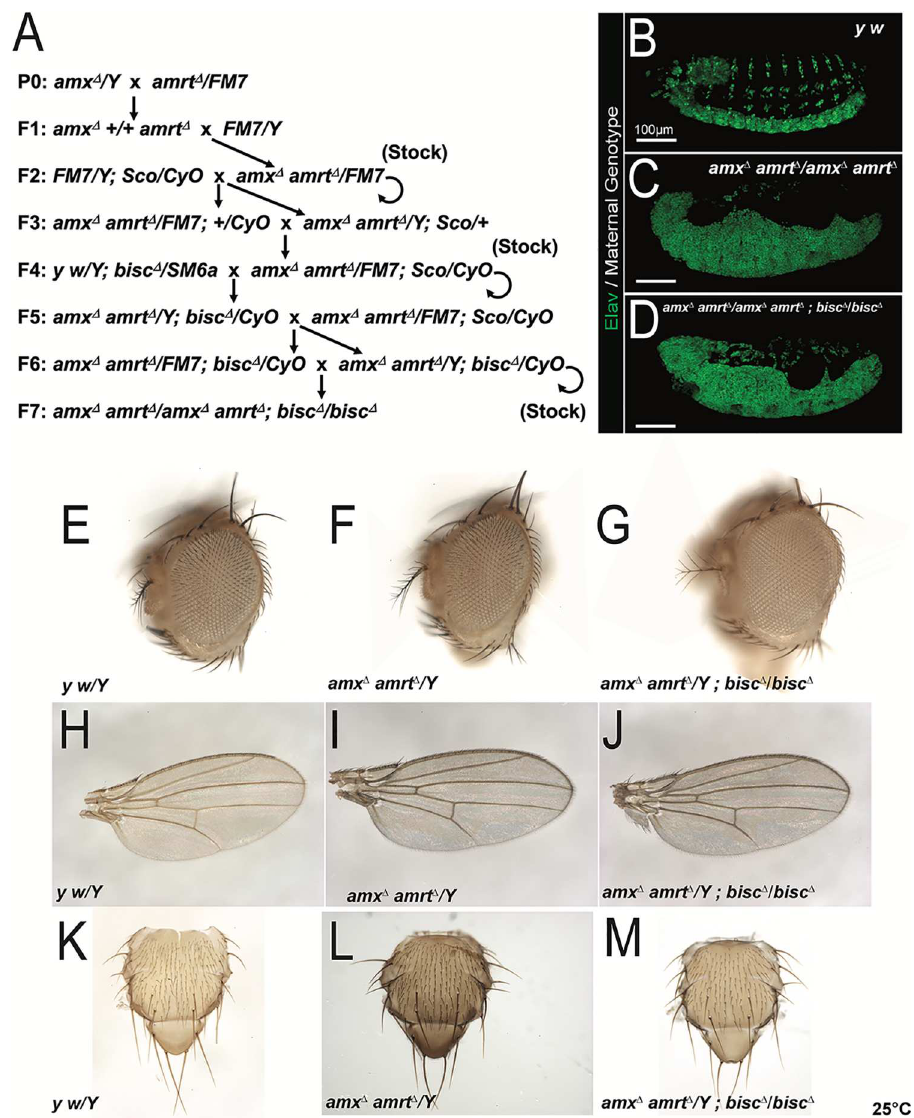
Fig 3. Triple null mutant for all three TM2D fly genes is phenotypically similar to single null mutants. (A) Crossing scheme used to generate TM2D triple null mutant flies. (B) A normal embryonic nervous system highlighted by neuronal nuclei marker Elav (green). (C-D) amx Δ amrt Δ double mutants (C) and amx Δ amrt Δ bisc Δ triple mutants (D) exhibit a neurogenic phenotype. (E-K) TM2D double and triple null mutants exhibit no overt morphological phenotypes. Head structures of mutants (F, G) appear normal compared to y w control (E). Mutant wings (I, J) and thorax (L, M) also appear normal compared to control (H, K). Scale bars = 100 μ m in (B-D). developmental contexts that are known to depend on Notch. To further study the function of TM2D proteins in vivo , we tested whether overexpression of Amx is sufficient to modulate Notch signaling ( Fig 4 ). In addition to generating transgenes that allow the expression of a full- length Amx protein with or without an N’-3xHA tag (placed immediately after the predicted signal sequence, 3xHA::Amx FL ) ( Fig 4A ) using the GAL4/UAS binary expression system [40], we generated a version of the N’-3xHA tagged construct that lacks the majority of the non-con- served N’-terminal extracellular domain (3xHA::Amx Δ ECD ) ( Fig 4D ) to specifically test the function of the highly conserved TM2 domain through overexpression experiments.